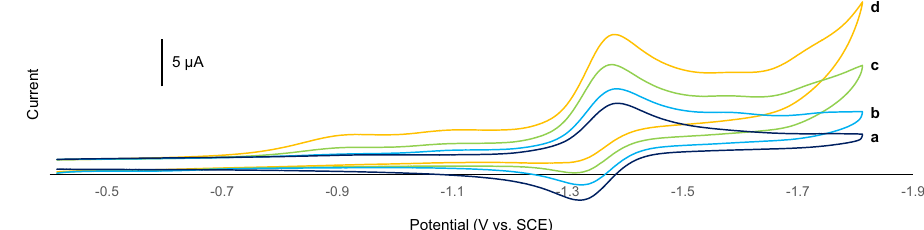
Fig. 3 Cyclic voltammograms of 3f in the presence of various amounts of ascorbic acid. Recorded at 100 mV/s in a DMF solution of 3f (0.50 mM) and Bu 4 NClO 4 (0.1 M). a In the absence of ascorbic acid. b 0.63 mM of ascorbic acid. c 1.5 mM of ascorbic acid. d 3.0 mM of ascorbic acid. The potential was